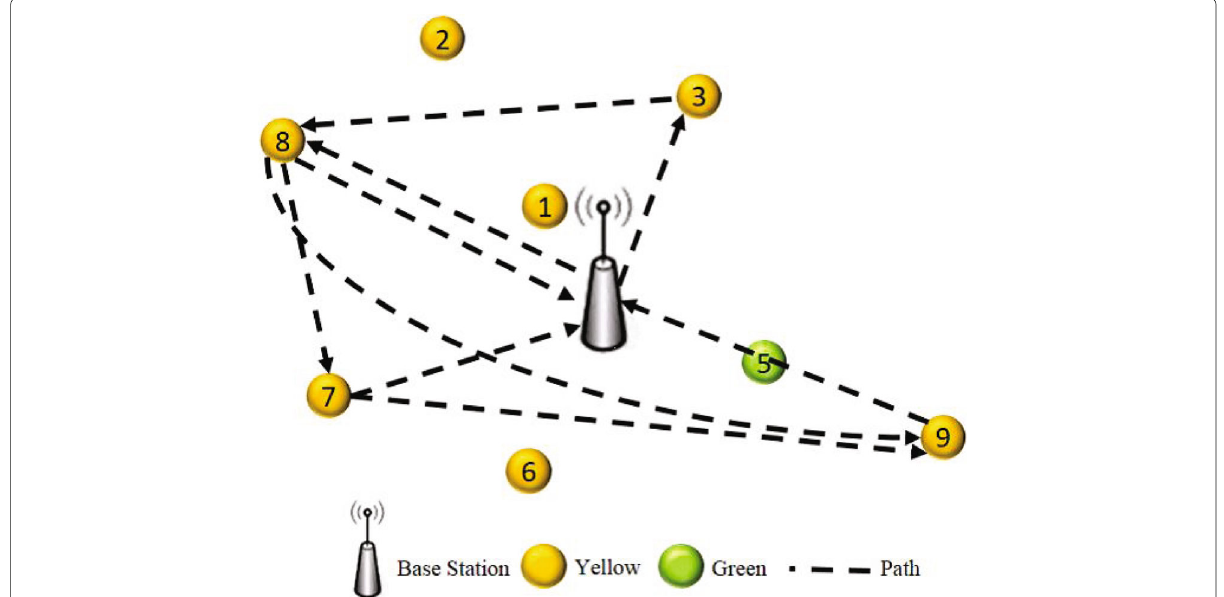
Fig. 9 The charging tour planning of the sensors in the yellow